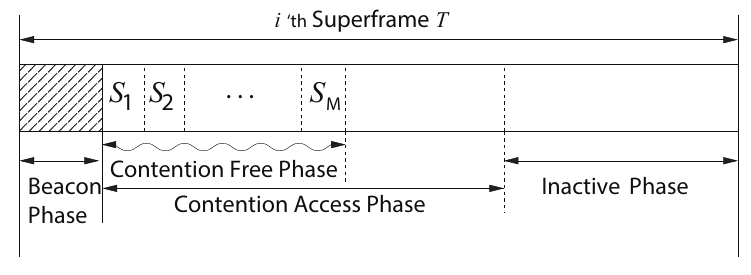
Figure 1. Contention over reservation (CoR)-MAC superframe